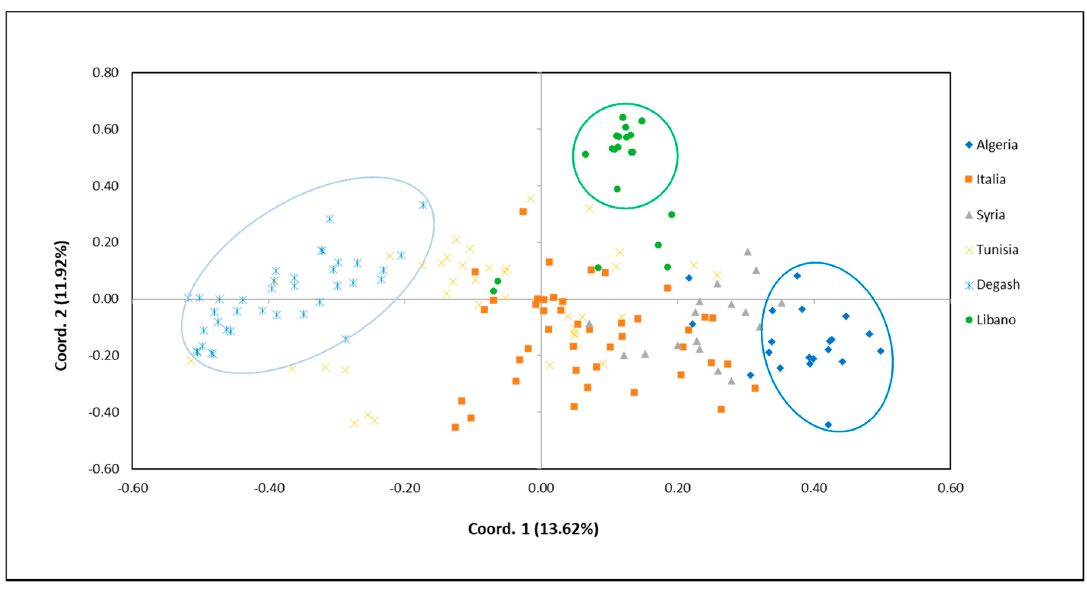
Figure 2. Principal coordinate analysis (PCoA) based on genetic distance between Degache olive samples and 140 varieties deriving from di ff erent geographical areas. Circles are drawn arbitrarily to emphasize the prominent groups of genotypes from Degache oasis (light blue), Algeria (blue), and Lebanon